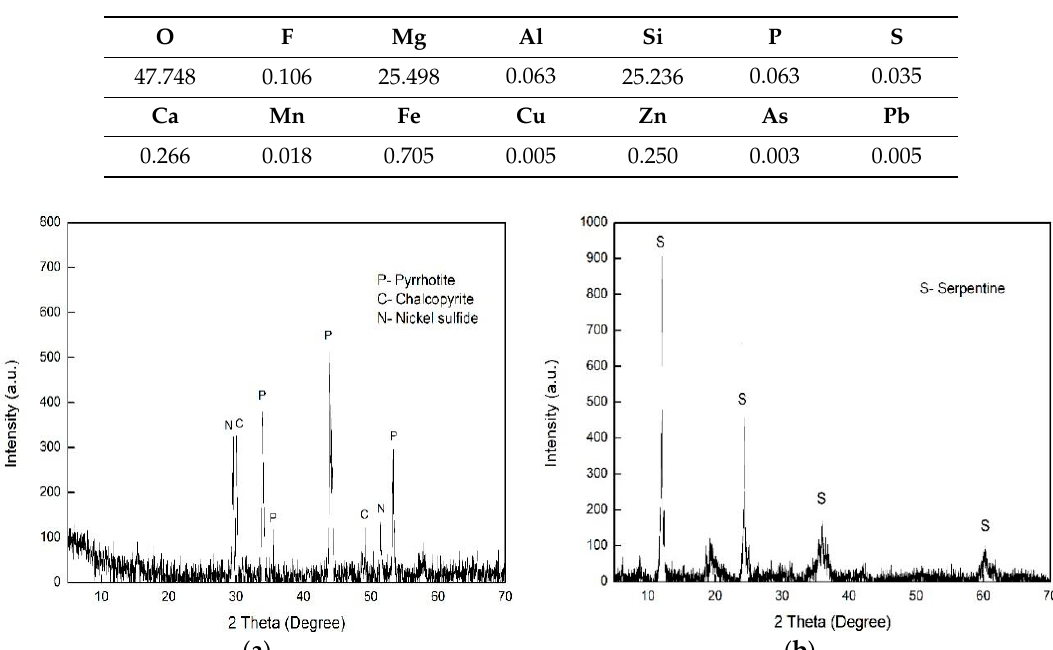
Table 2. Key element composition of serpentine (wt %).